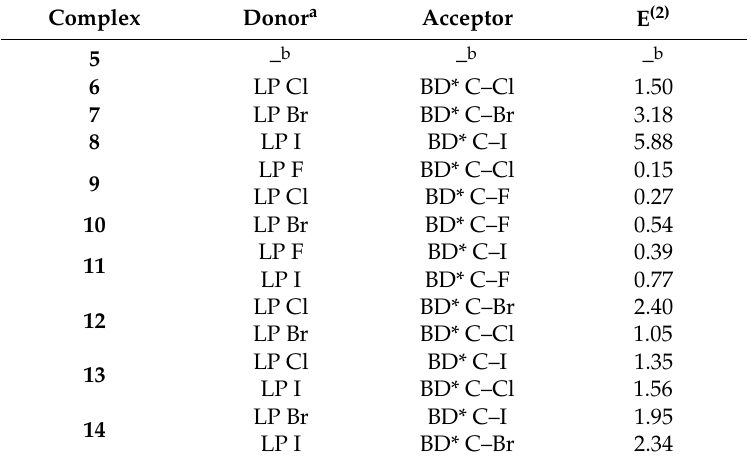
Table 2. Donor and acceptor natural bonding orbitals (NBOs) with an indication of the second-order interaction energy E (2) (kcal/mol) and type of interaction for complexes 5 – 14